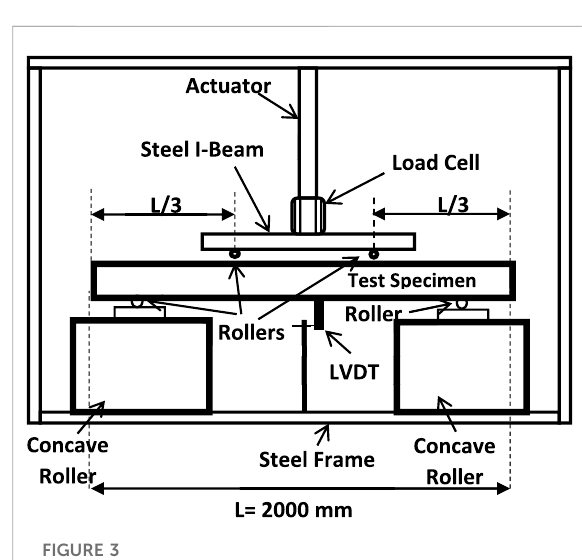
FIGURE 3 Loadingcon fi gurationfor static testing(Karalar,2020;Karalar et al.,